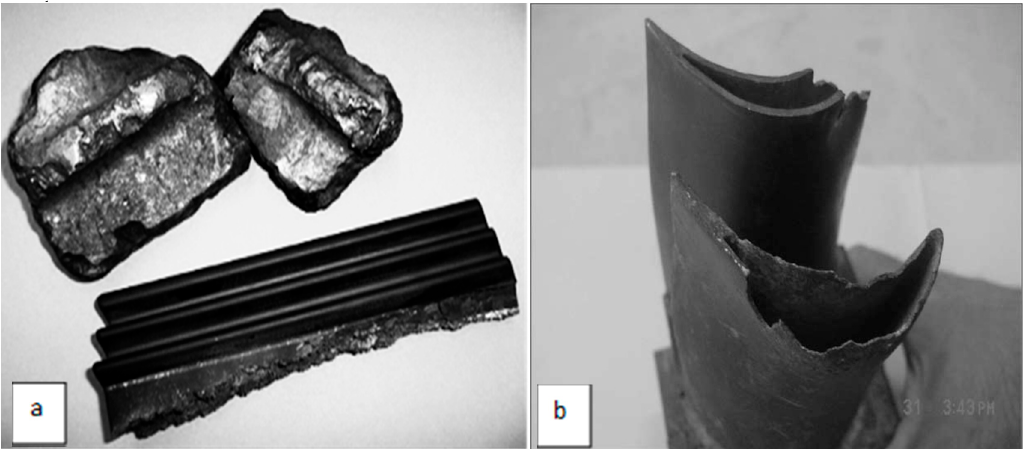
Figure 4. Wear damage of gas turbine components: ( a ) fretting wear damage for turbine blade GTD 111 (Barella et al., 2011); b ) erosive wear on gas turbine blades (Khajavi and Shariat, 2004).